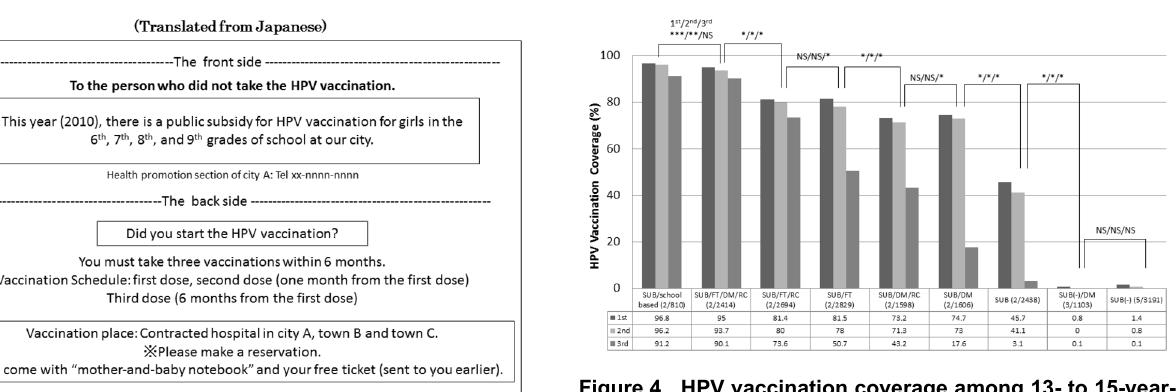
Figure 4. HPV vaccination coverage among 13- to 15-year- old females according to combinations of